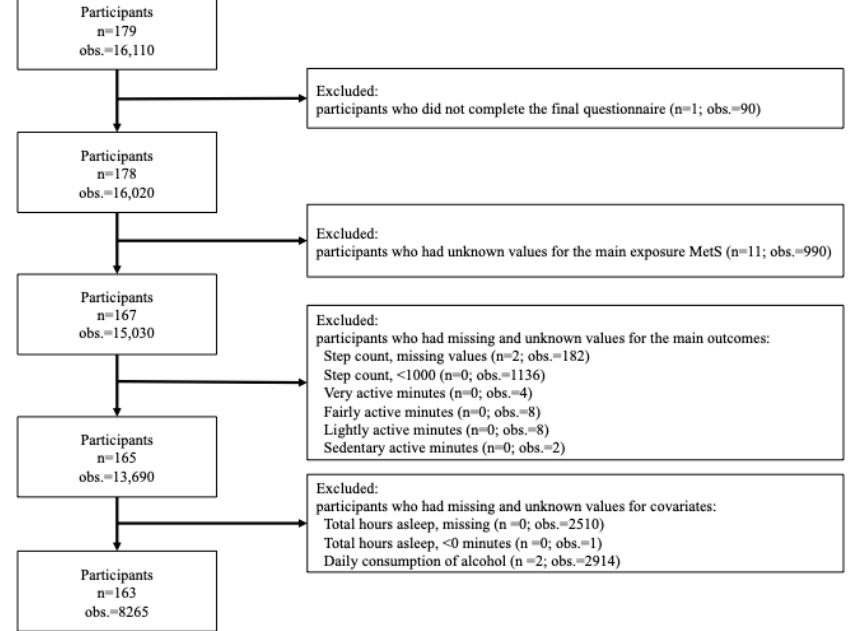
Figure 1. Flowchart detailing the inclusion and exclusion of participants and observations in the present study. Abbreviations: obs: observations.